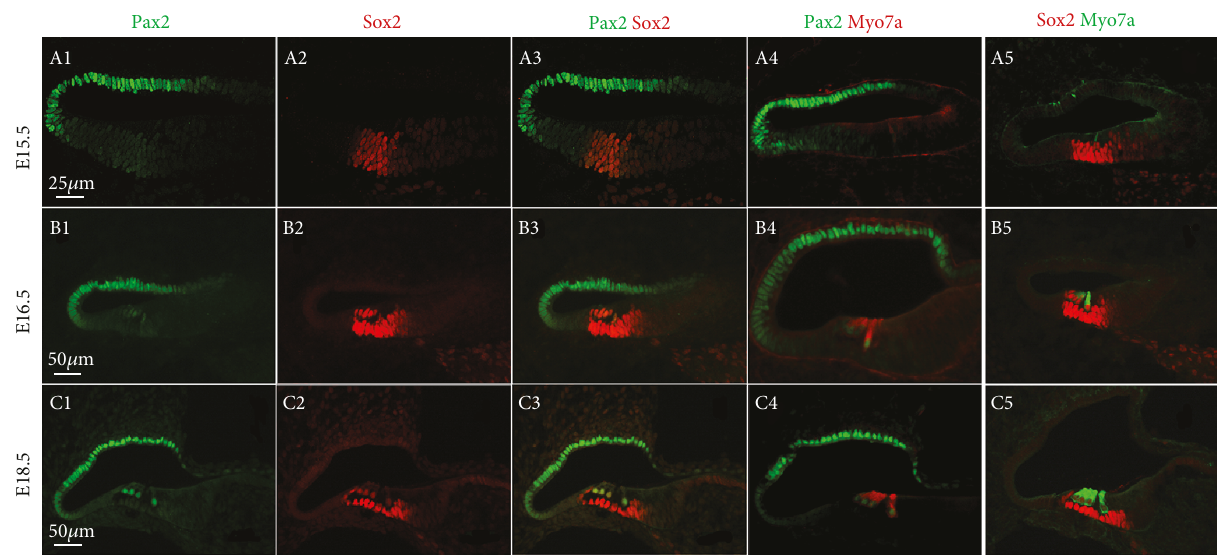
Figure 2: Comparison of Pax2, Sox2 expression in the cochlea. Immuno fl uorescence of Sox2, Pax2, and myosin7a expression in the cochlear duct at E15.5, E16.5, and E18.5. Scale bars =25 μ m (A1 – A5); 50 μ m (B1 – B5 and C1 – C5).